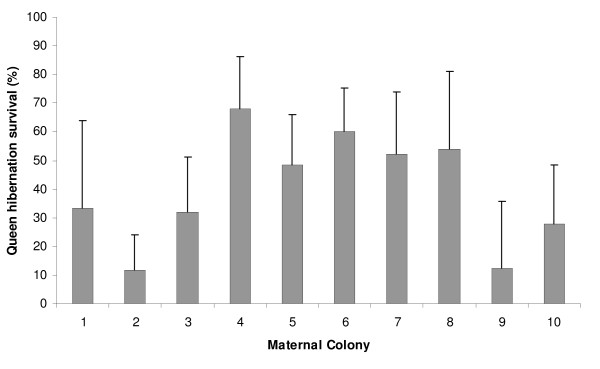
Hibernation survival for experimental queens from each maternal colony. The probability of surviving differed significantly between maternal colonies (P < 0.0001). Sample size within each maternal colony ranged from 8 to 40 and error bars show 95% shortest unbiased confidence limits.